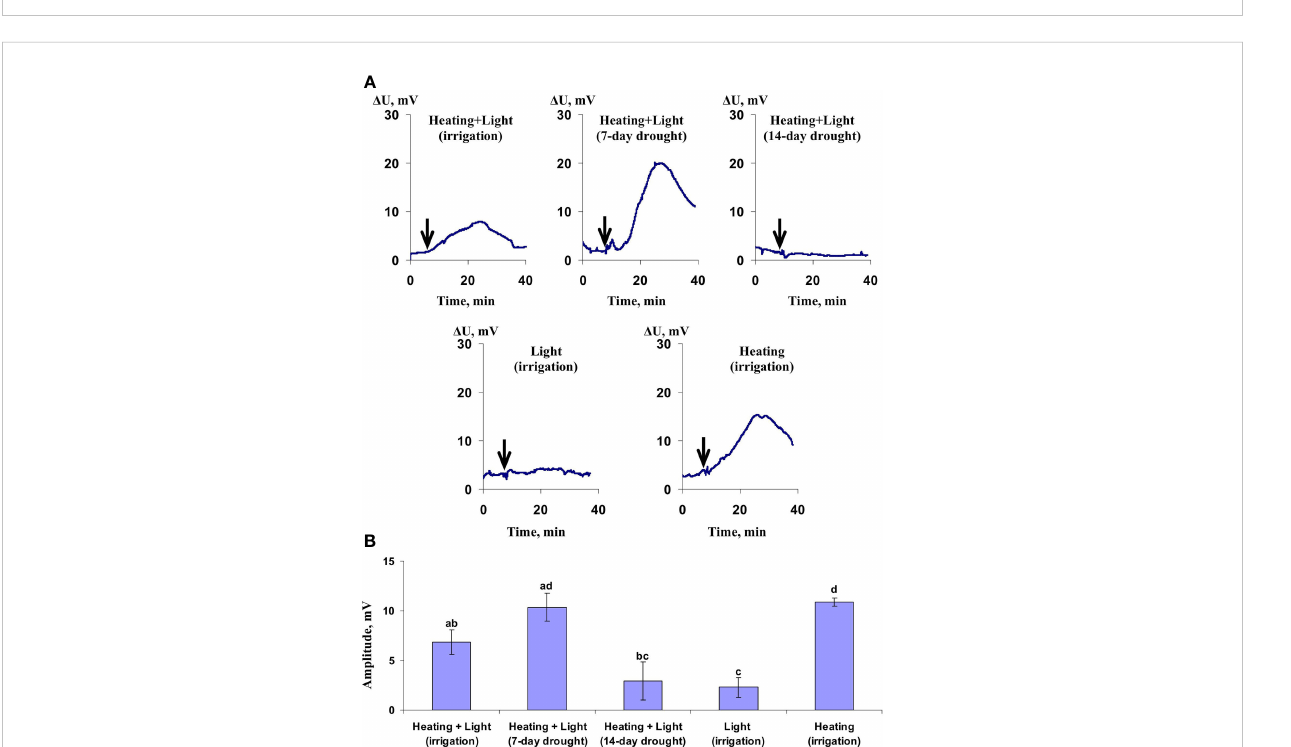
FIGURE 14 Records of hyperpolarization signals induced by different variants of local irritations (Heating+Light, Light, or Heating) under irrigation, 7-day, or 14- day soil drought (A) and average amplitudes of these signals ( n =7-12) (B) . Hyperpolarization signals in the 5 cm distance from the irritated zone were only measured and analyzed. Different letters mark signi fi cant differences ( p <0.05, Student ’ s